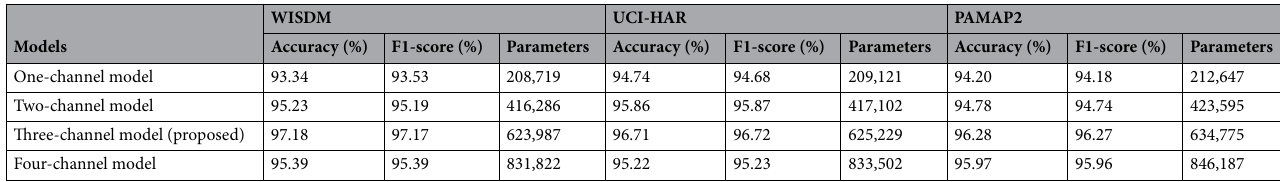
Table 11. Performance comparison of the models with different number of channels.